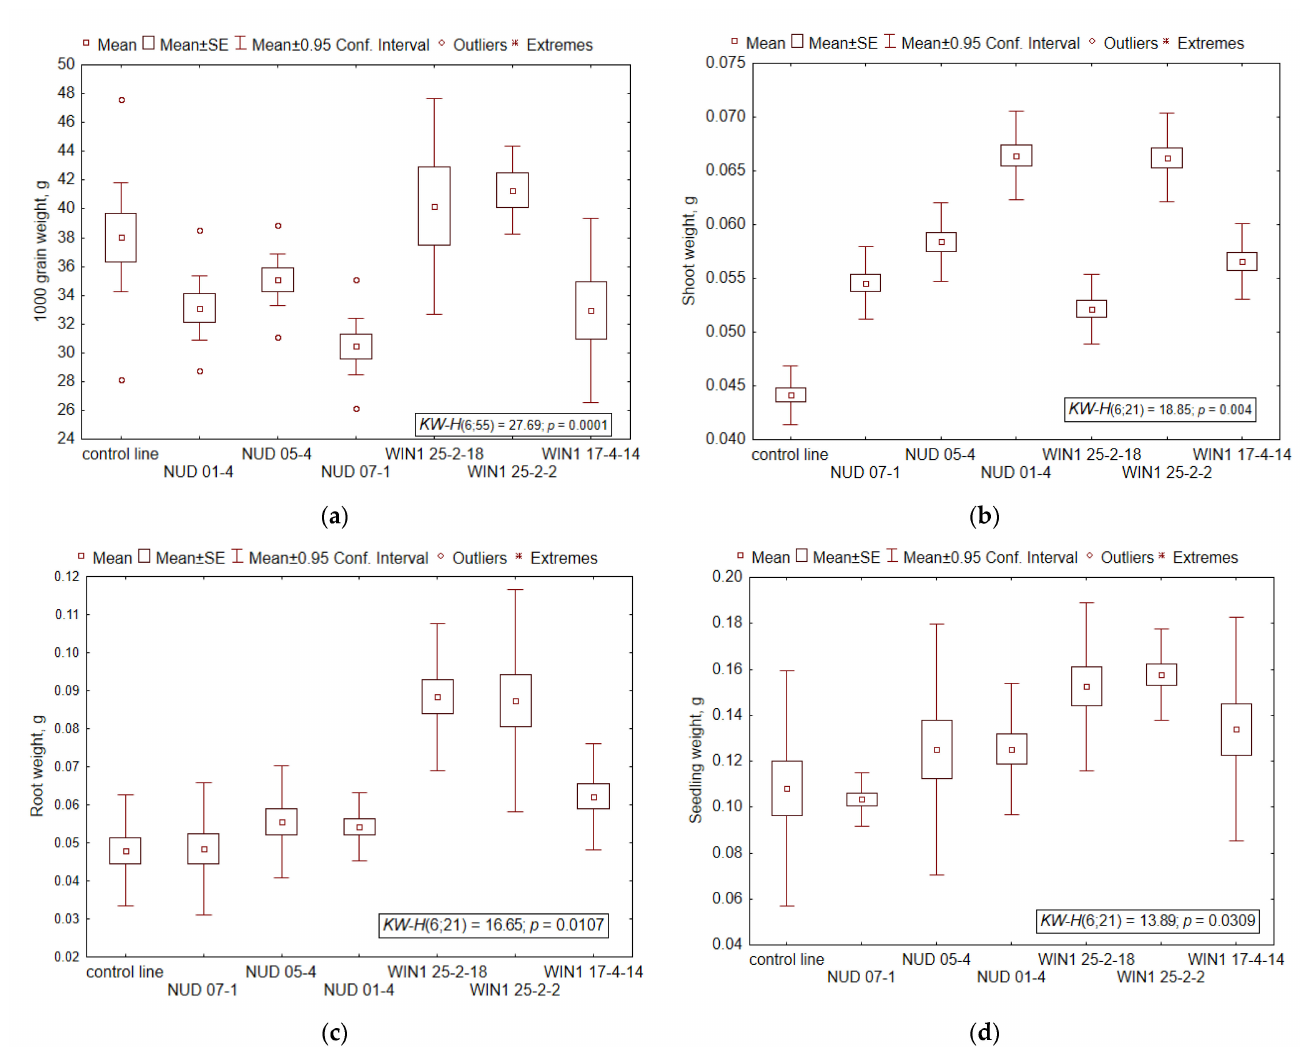
Figure 1. Variation of air-dried weights of grains and seedlings of nud KO and win1 KO barley lines: ( a ) grains (number of samples for each line, N = 4–10), ( b ) shoots ( N = 3), ( c ) roots ( N = 3), and ( d ) seedlings ( N = 3). The mean values, standard error (SE) and 95% confidence interval are indicated in the Figure 1. The nonparametric Kruskal-Wallis (KW) method was used, where H is the criterion value, p -value is the significance level. The degree of freedom ( df ) values of the numerator and denominator of H -criterion are given in